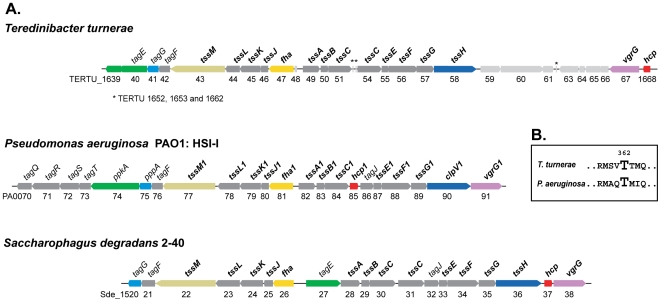
Type 6 secretion system (T6SS) gene clusters.(A) Schematic representation of T6SS clusters of T. turnerae, P. aeruginosa and S. degradans. The T6SS units are arranged so that the fha ortholog of each species is central. Genes are identified by locus tag numbers (below) and according to the standardized nomenclature for T6SS proposed by Shalom et al.
[103] (above): tss; core components in all T6SS units; tag: tss-associated genes which are present in T6SS clusters in more than one bacterial species. Genes highlighted in color are discussed in the text and homologous genes are represented by the same color. Genes indicated with light grey have not been clearly linked to T6S function or are not widely conserved in T6S loci. T6SS core genes [104] are indicated in bold type. (B) Partial sequence alignment of the FHA domain-containing proteins involved in posttranslational regulation of T6S in T. turnerae and P. aeruginosa. The critical phosphorylation site (Thr362) is conserved in the T. turnerae protein.